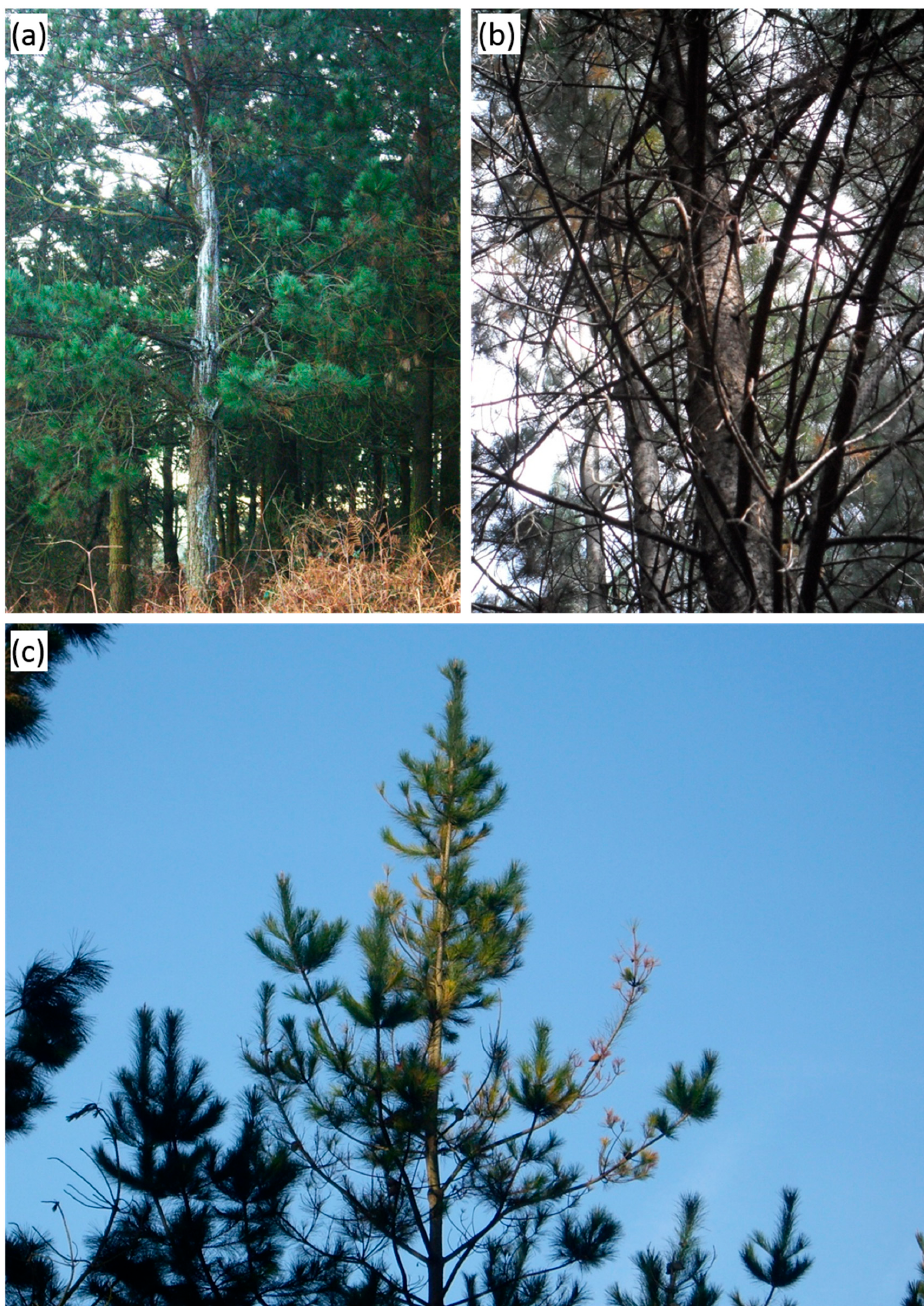
Figure 1. Pine pitch canker (PPC) symptoms of ( a ) cankers, ( b ) defoliation, and ( c ) dieback.